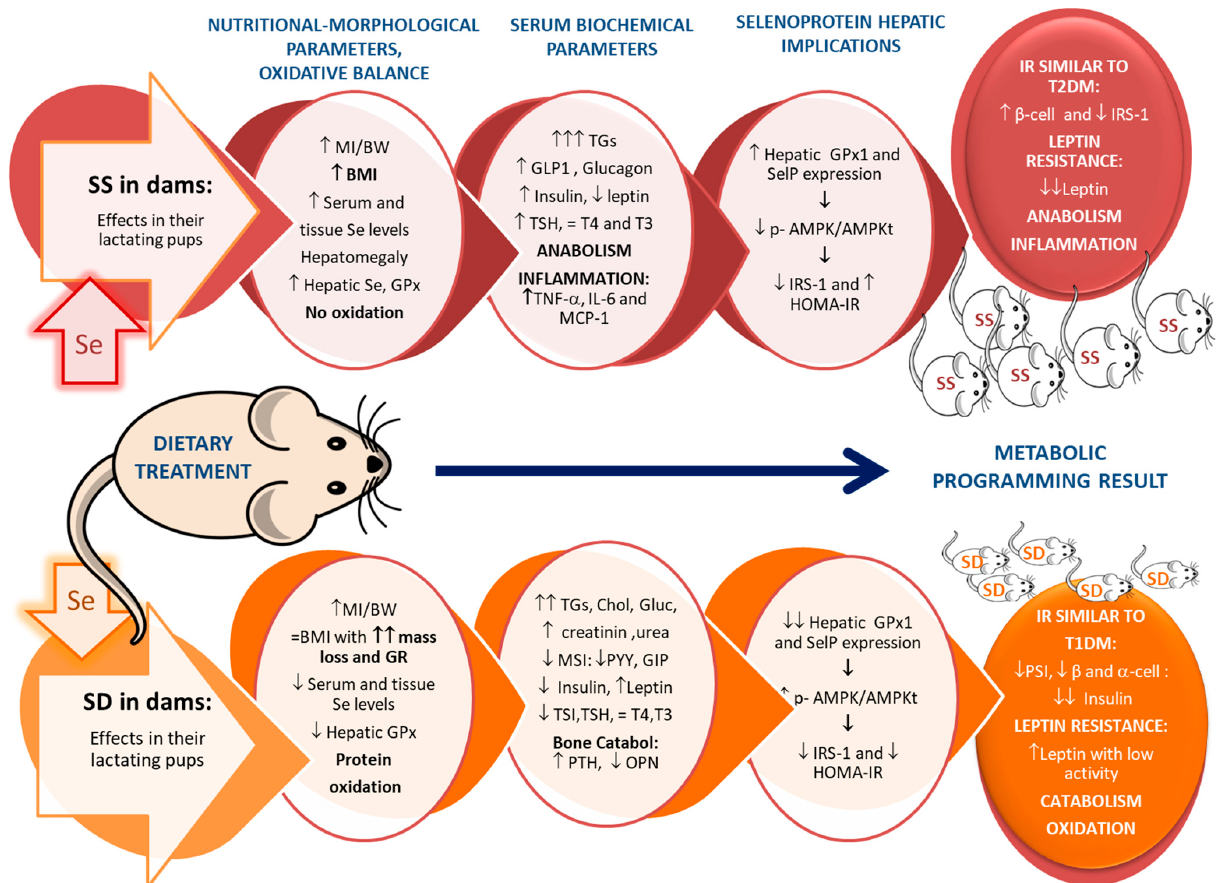
Figure 3. Maternal selenium status and metabolic programming. Effects of maternal Se diet on their offspring: nutritional-morphological parameters and oxidative balance; biochemical parameters; hepatic selenoproteins’ expression and metabolic programming results. SS: selenium supplemented dams (0.5 ppm); SD: selenium deficient dams (0.01 ppm). MI: milk intake, BW: body weight; BMI: body mass index, GR: growth retardation, GPx: glutathione peroxidase, TGs: tri-